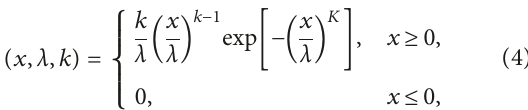
Figure 10: Failure mode of rock depending on the loading rate. (a) #2 (loading rate (c) #6 (loading rate 0.07mm/min), and (d) #8 (loading rate (cid:31)